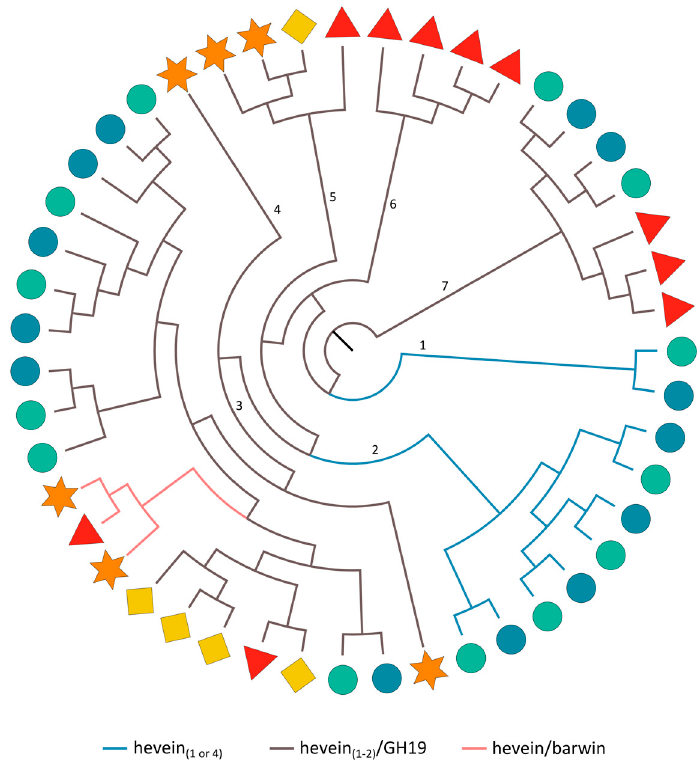
Figure 7. Midpoint rooted cladogram constructed with all hevein domain sequences from Arabidopsis (red triangle), soybean (orange star), cucumber (yellow rhomb) and rice ( japonica : green circle, indica : blue circle). Numbers indicate the clade numbers and the colored branches correspond to the different domain architectures of the full-length hevein sequences.